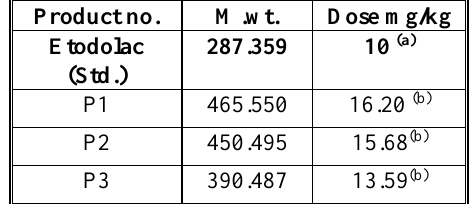
Table (1) Doses determined for the synthesized final products Product